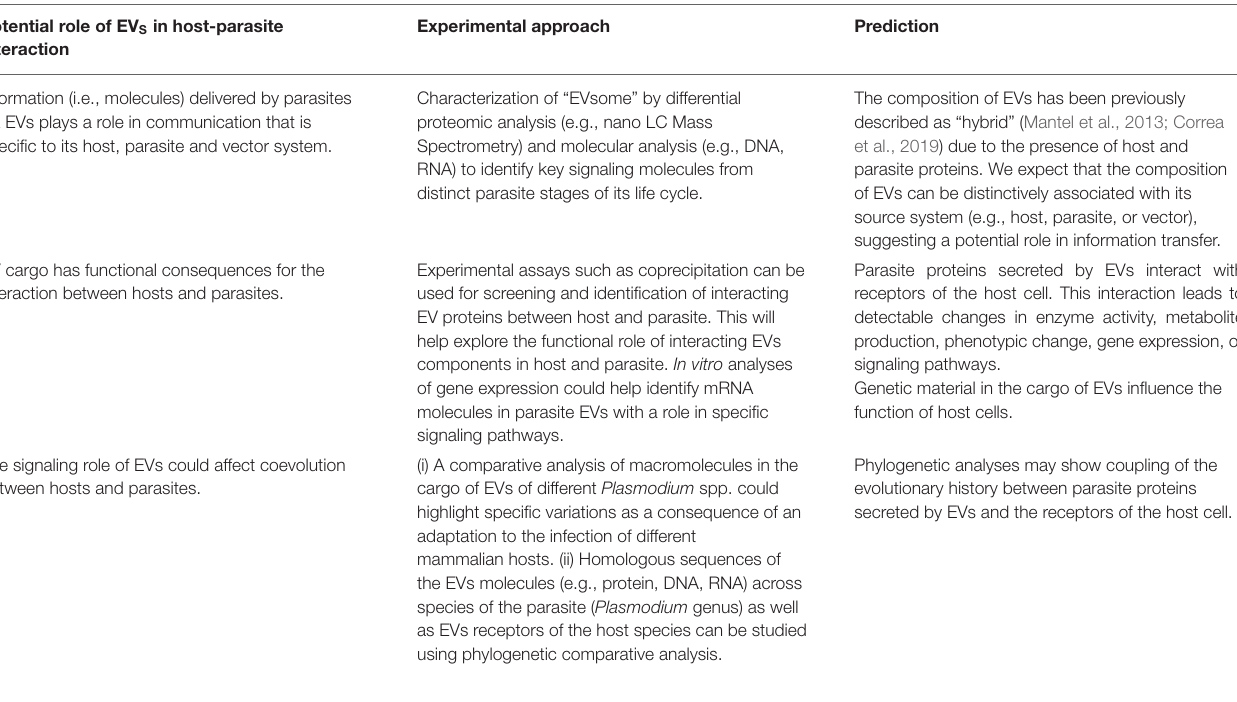
Experimental approach